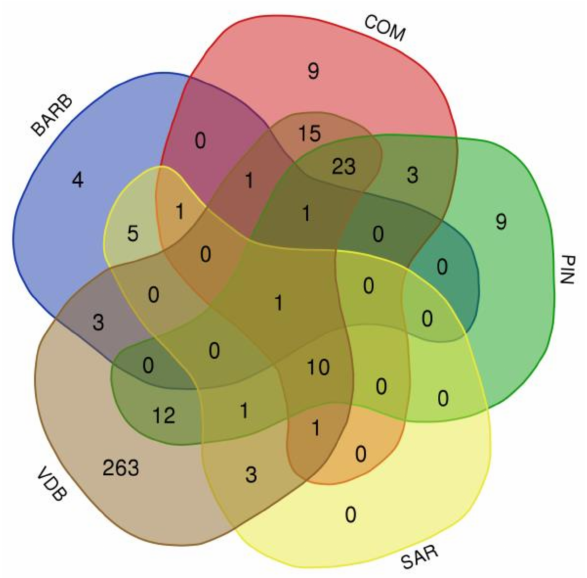
Figure 2. Venn diagram representing common and unique CNVRs found among the five breeds. Barbaresca (BARB), Comisana (COM), Pinzirita (PIN), Sarda (SAR), and Valle del Bel ì ce